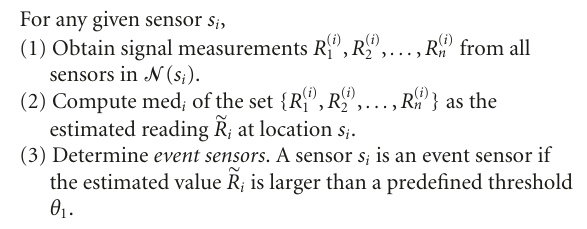
Algorithm 1: For target region detection.